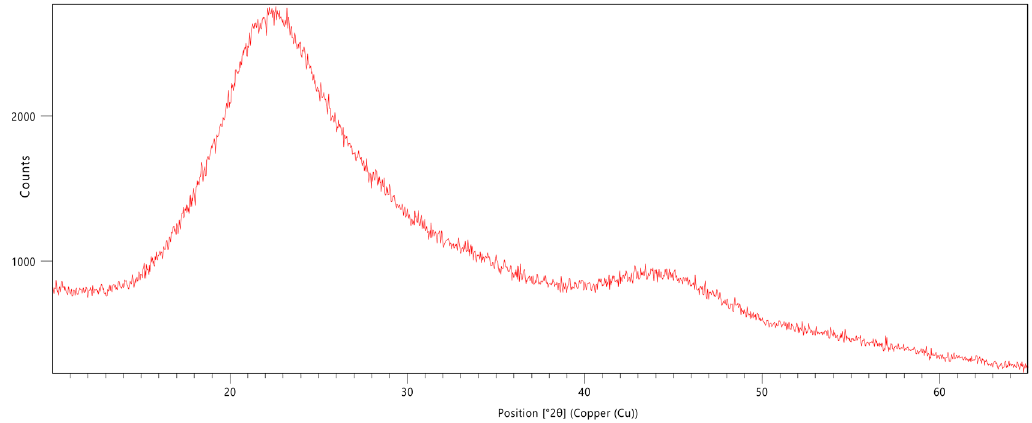
Figure 5. X-ray diffraction analysis of monoclinic boric acid.